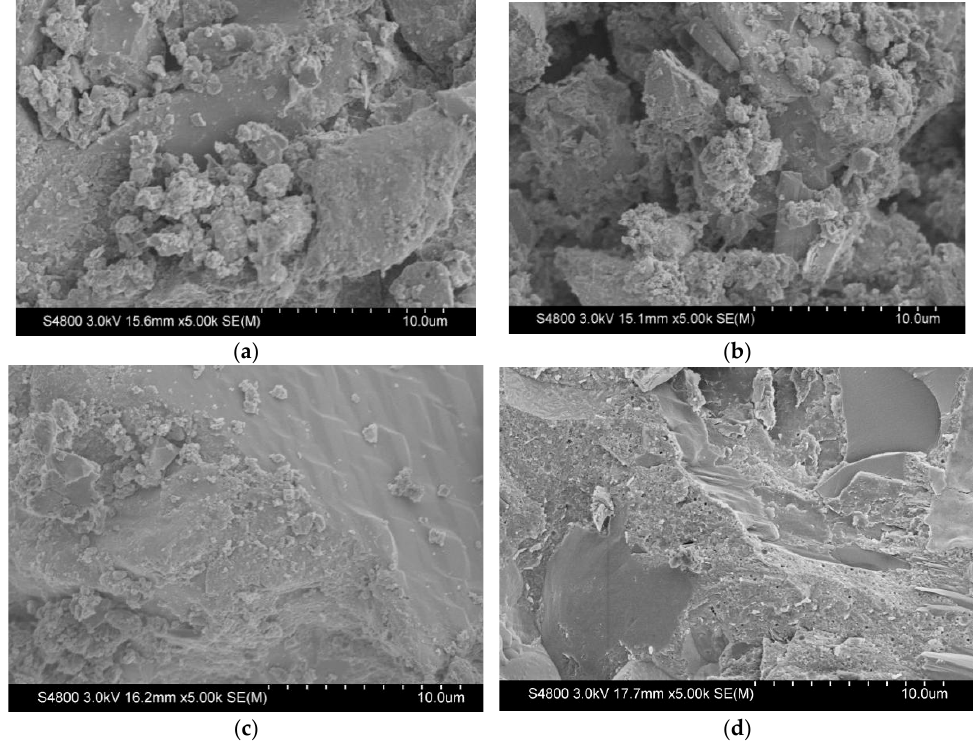
Figure 9. SEM images of UHPC specimens in each group. ( a ) B group. ( b ) R1 group. ( c ) R4 group. ( d ) R5 group.